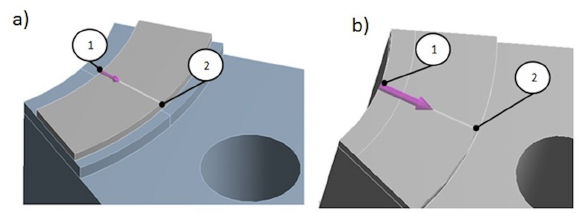
Figure 10: Defined measuring paths a) on the gasket b) on the